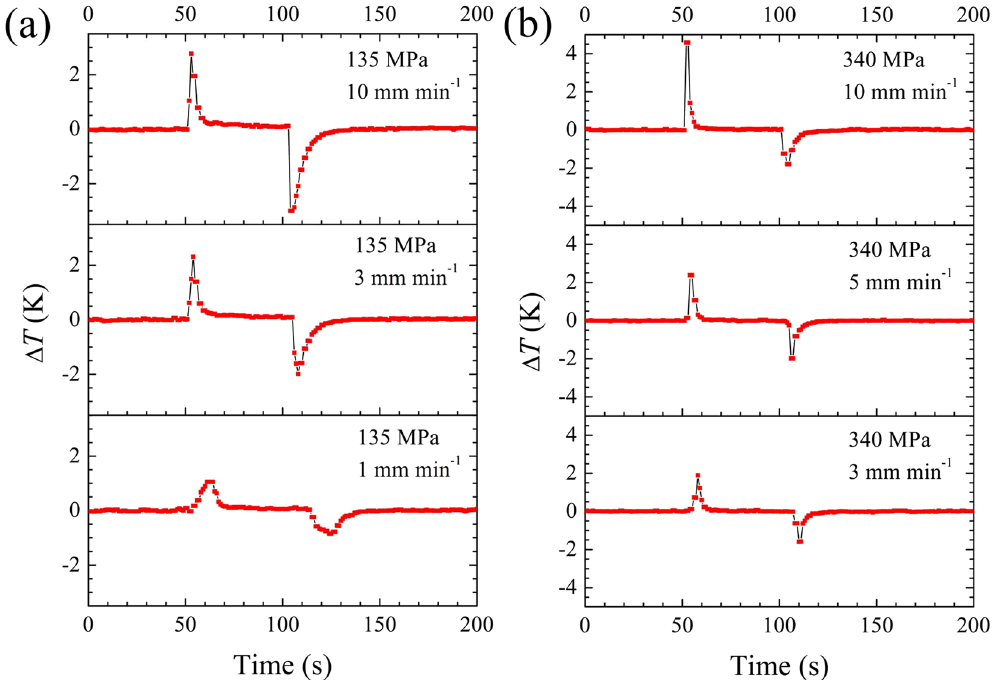
Figure 2. Strain-rate dependence of temperature-time profiles for narrow- stress-hysteresis Ni 45 Mn 50 − x In x Co 5 samples at room temperature: ( a ) x = 13.6, T test = 293 K, and ( b ) x = 14.0, T test = 287